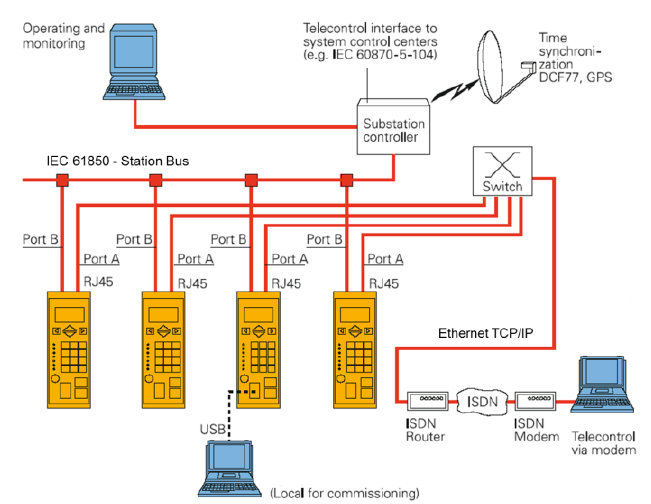
Fig. 1. Typical architecture for substation